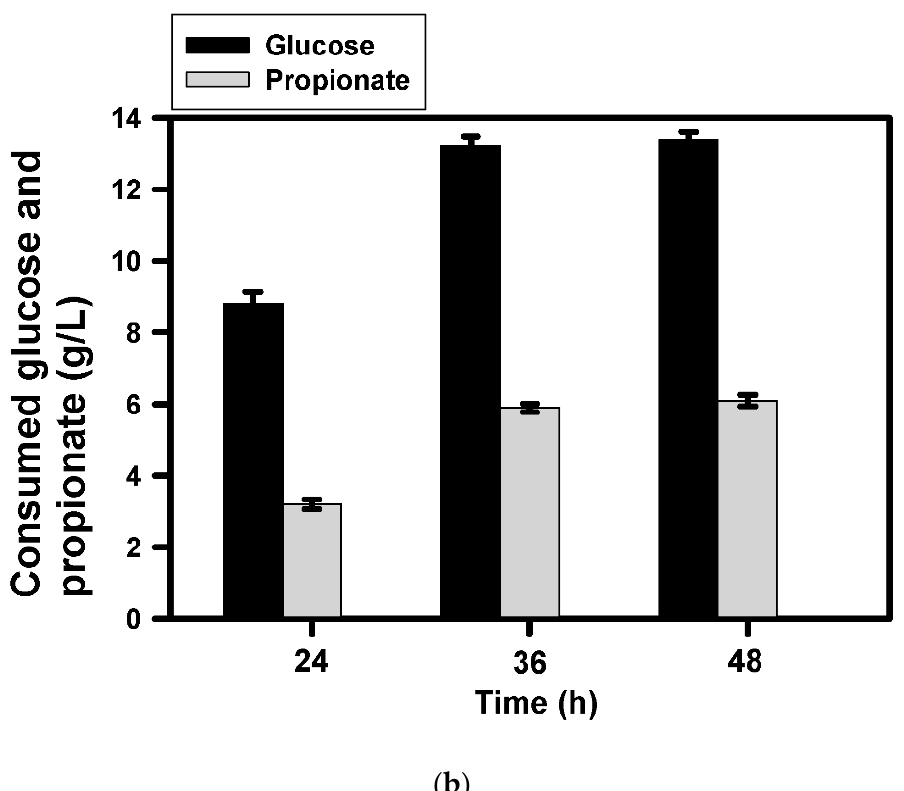
Figure 3. Production of 1-propanol by the approach of substrate feeding. The fermentation of BuT-3E strain was carried out with glucose (10 g/L) and propionate (4 g/L). At 24 h, the substrate containing glucose (10 g/L) and propionate (4 g/L) was added to the culture medium and the fermentation result was analyzed at a predetermined interval. The experiment was conducted in triplicate. The fermentation products and the cell density (OD 550 ) were determined at the end of the fermentation ( a ). The consumption of glucose and fatty acids were measured for further analyses ( b ).